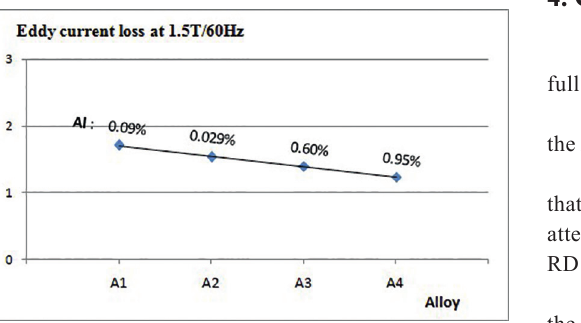
Figure 6: Variation of eddy-current loss as function Al content.